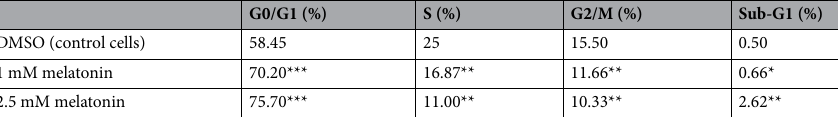
Table 3. The mean percentage of cells in each phase of the HepG2 cell cycle for each treatment of melatonin after 24 h incubation time. *** P < 0.001, ** P < 0.01, and * P <